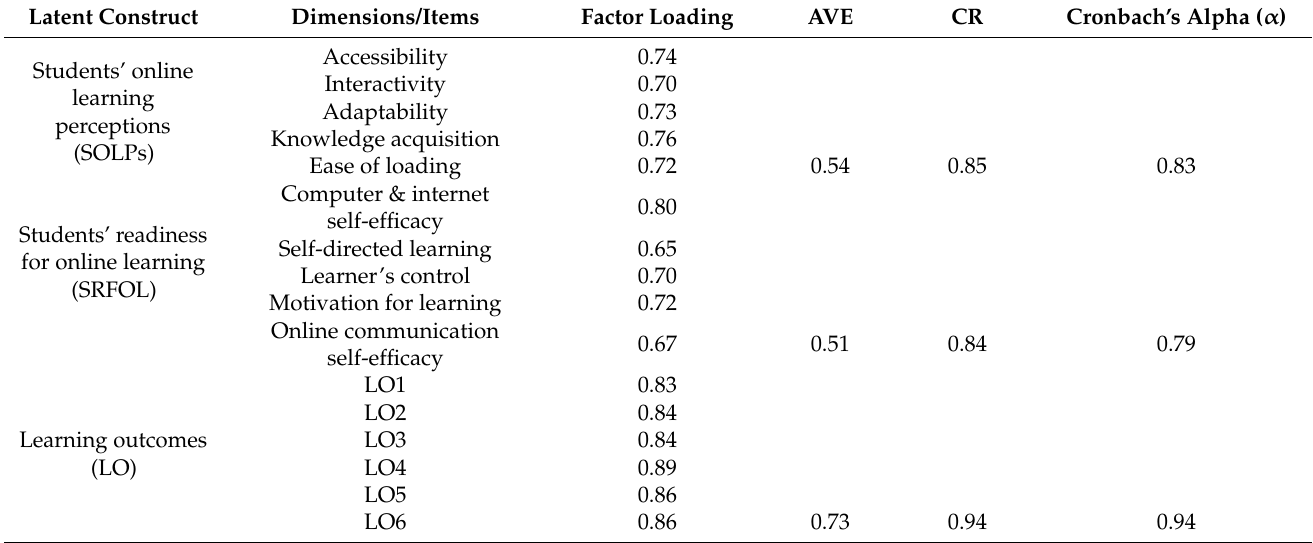
Table 1. Second-order measurement model results (Level-1).